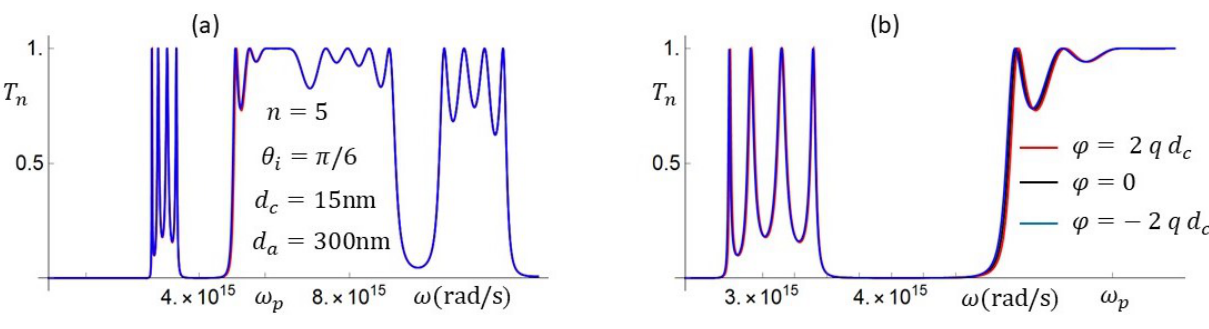
Figure 16. The effect of phase ϕ in the transmission coefficients. The graph in subfigure ( b ) is a zoom of the graph in subfigure ( a ). The effect of the phase ϕ is negligible, and null for frequencies above ω p